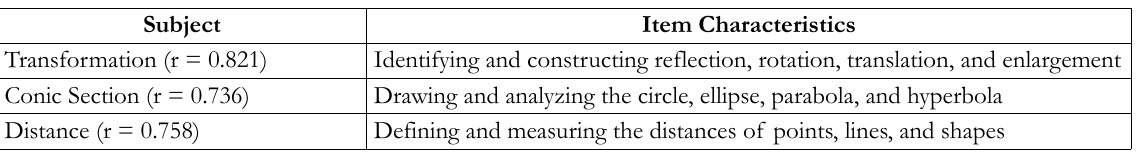
Table 1. Subjects in the Geometry Analytic Instrument